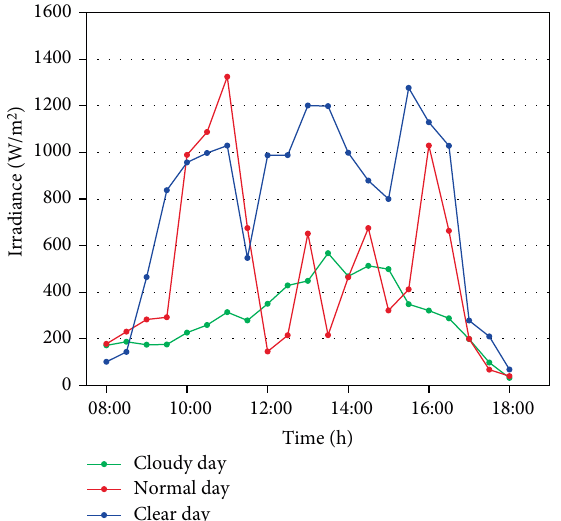
Figure 5: Variation of solar irradiation at different test conditions.